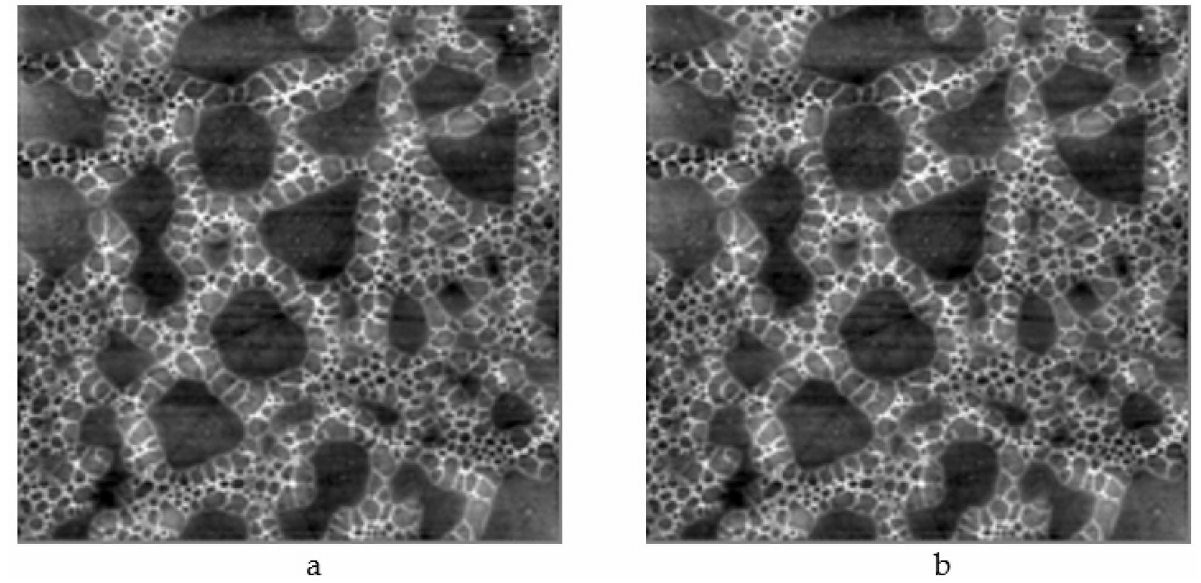
Figure 6. Atomic-force microscopy images of hierarchical porous nano-composites: ( a ) a two-component system of silicon and tin oxides (image size 10 µ m × 10 µ m); ( b ) a three-component system of silicon, iron and erbium oxides (image size 50 µ m × 50 µ m).